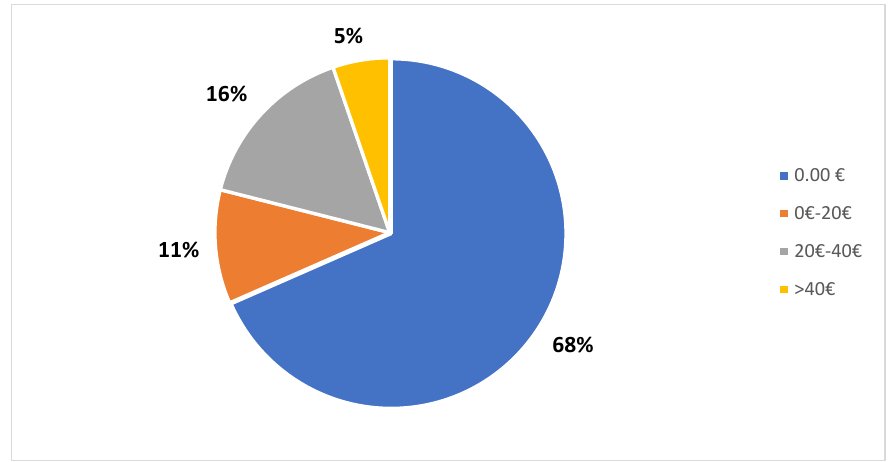
Figure 20. Acceptable monthly fee for the installation of a charger.